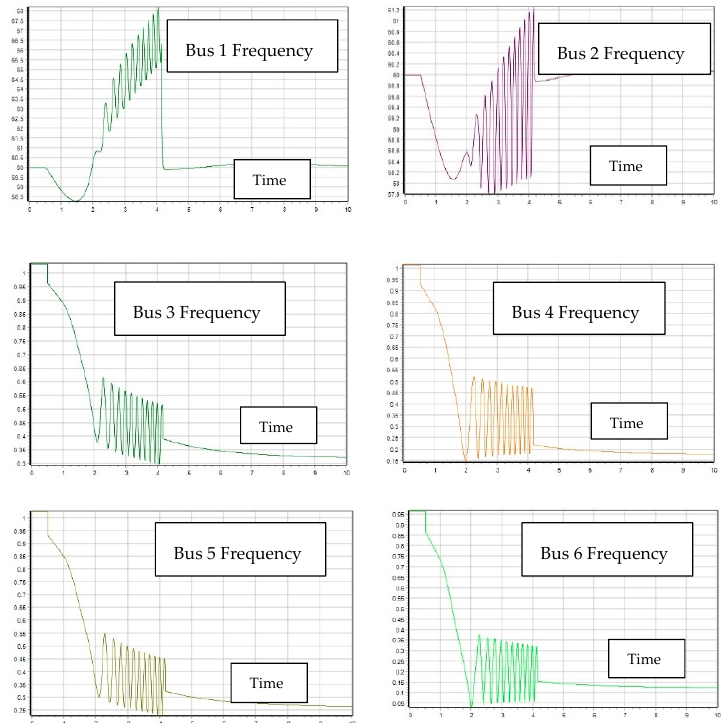
Figure 17. Bus frequency for second transient contingency scenario.